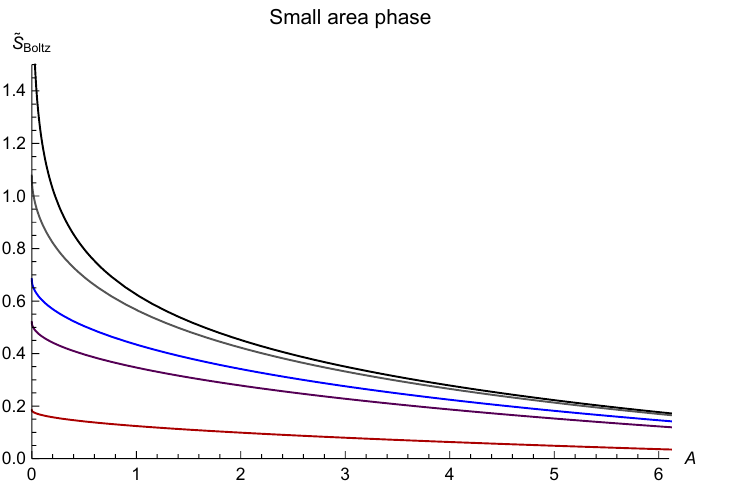
Figure 7 . Entanglement entropy of TT -deformed Yang-Mills theory at large N , normalized by N 2 and per number of entangling points, as a function of the area A in the weak coupling phase. The different curves correspond to the values τ = 0 (black), τ = 0 . 1 (gray), τ = 0 . 5 (blue), τ = 1 (purple), and τ = 5